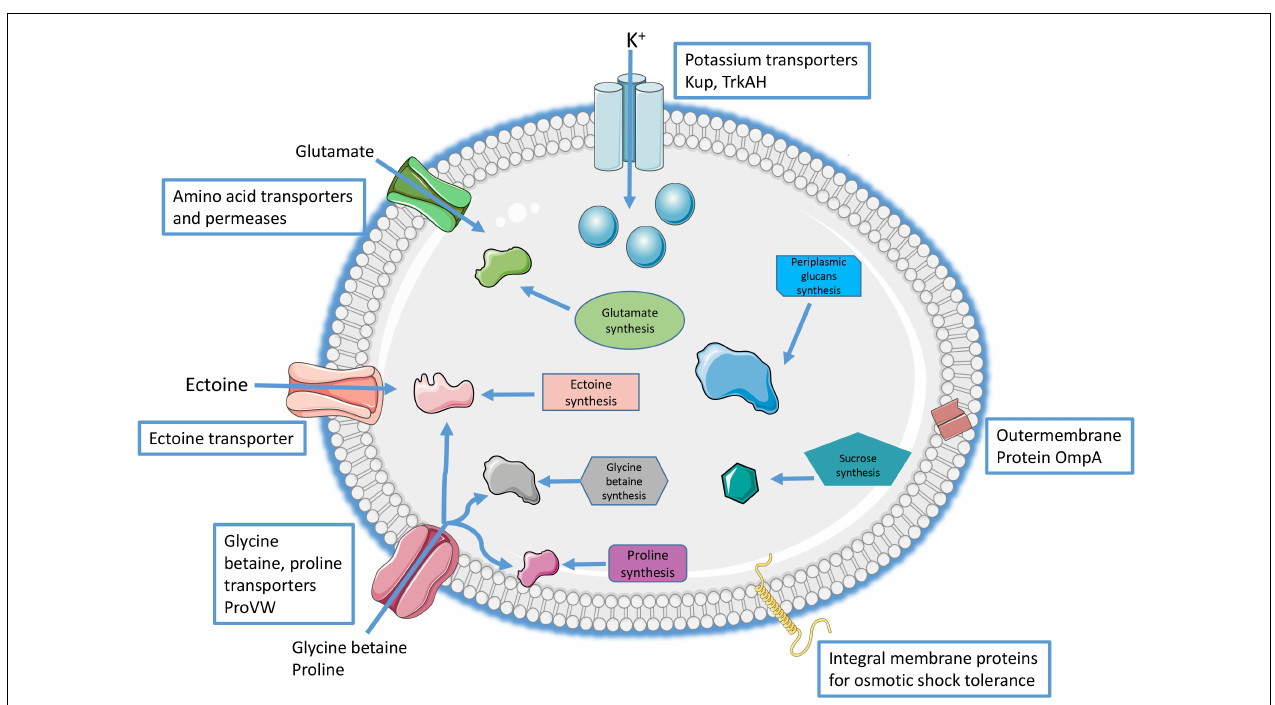
FIGURE 3 | Potential mechanisms of halotolerance shared by the members of the Acidihalobacter